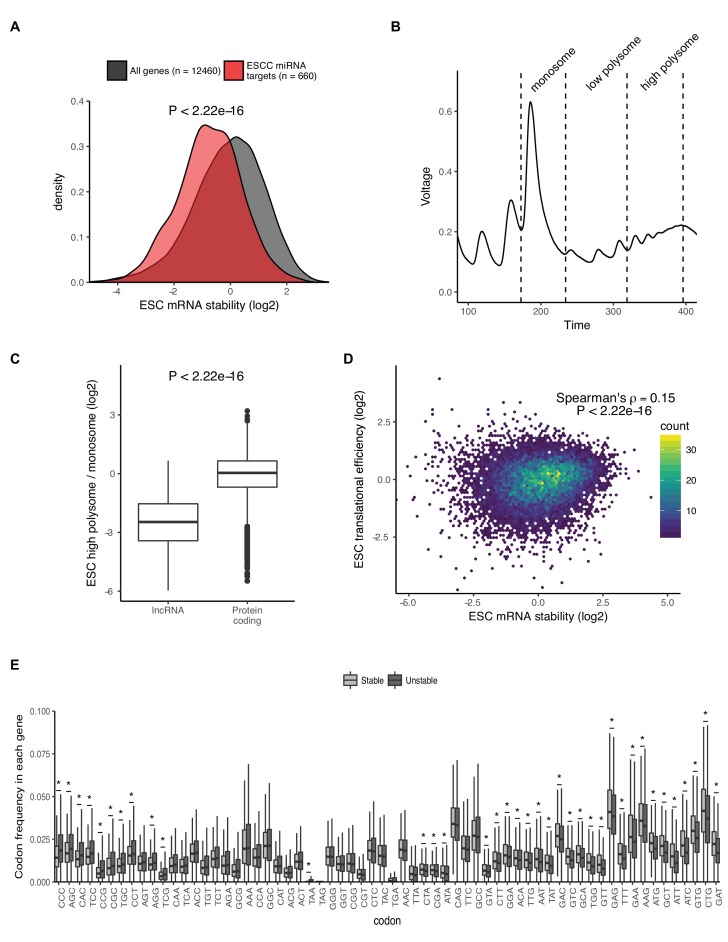
Factors that affect RNA stability in ESCs.(A) mRNA stability of ESCC miRNA targets compared to all mRNAs. The p value was calculated using the Mann–Whitney test. (B) Polysome trace showing monosome, low polysome, and high polysome fractions collected for RNA-Seq. (C) Translation level of long non-coding RNAs (lncRNAs) compared to protein coding RNAs. The p value calculated with Mann-Whitney test. (D) Comparison between mRNA stability and translational efficiency in ESCs. The p value calculated with correlation significance test. n = 3. (E) Boxplots showing the codon usage frequency in the top and bottom 20% of genes in terms of stability. Codons are ordered along the X-axis based on the median codon usage in unstable - median codon usage in stable. * indicates p<0.05 calculated using the Mann–Whitney test followed by Bonferroni correction.